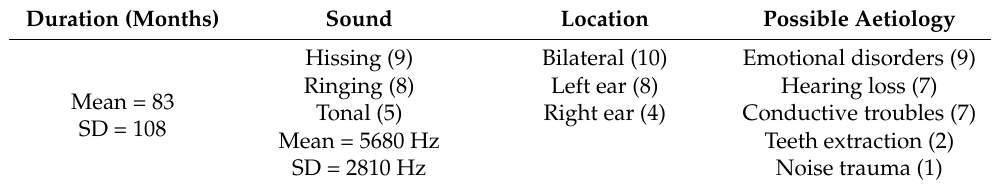
Table 1. Tinnitus characteristics of participants.